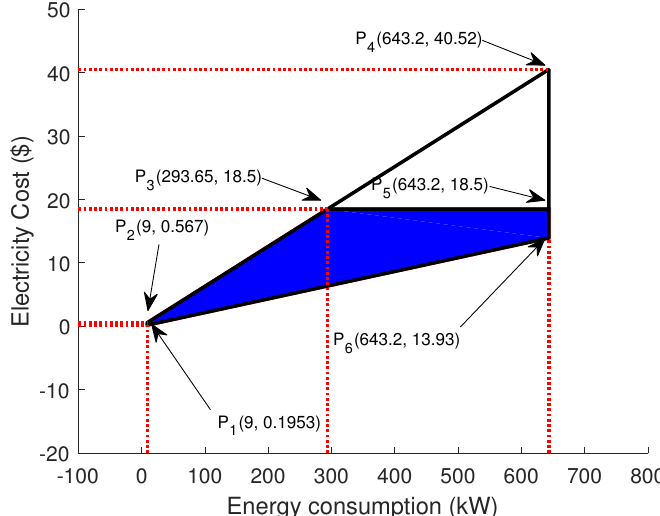
Figure 8. Feasible region of objective function.